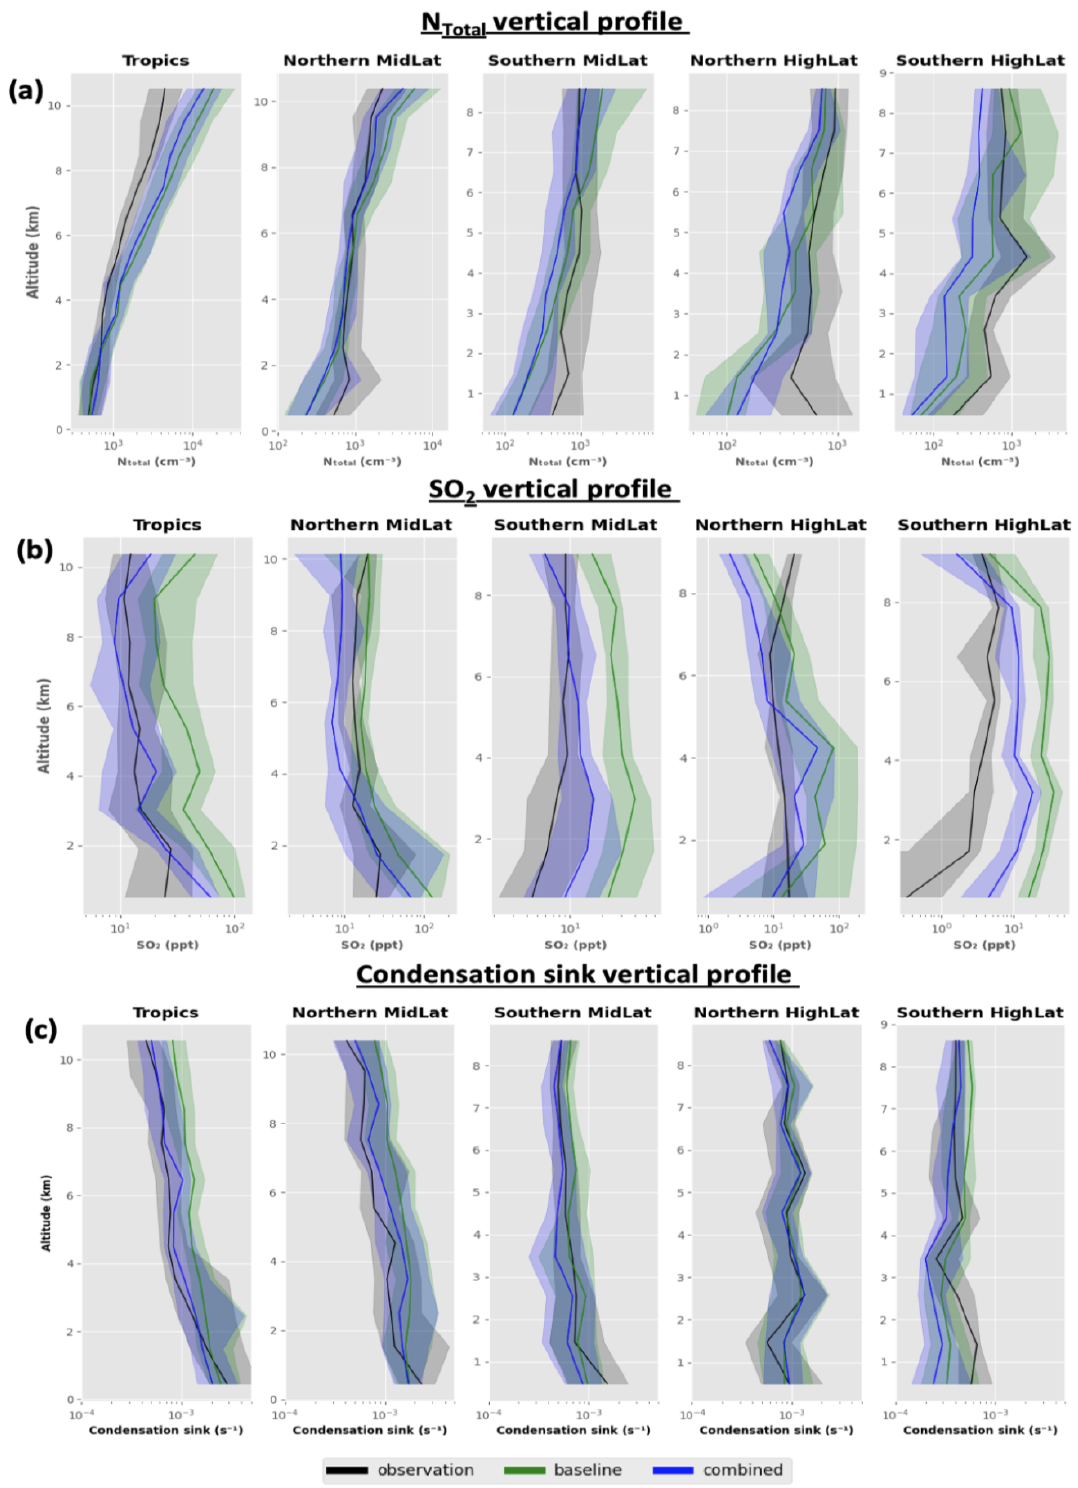
Figure A9. The vertical profiles for the baseline simulation and the combined simulation (a) N Total , (b) SO 2 , and (c) condensation sink in the tropics (25 ◦ S–25 ◦ N), northern mid (25–60 ◦ N) and high latitudes (60–90 ◦ N), and southern mid (25–60 ◦ S) and high latitudes (60–90 ◦ S).